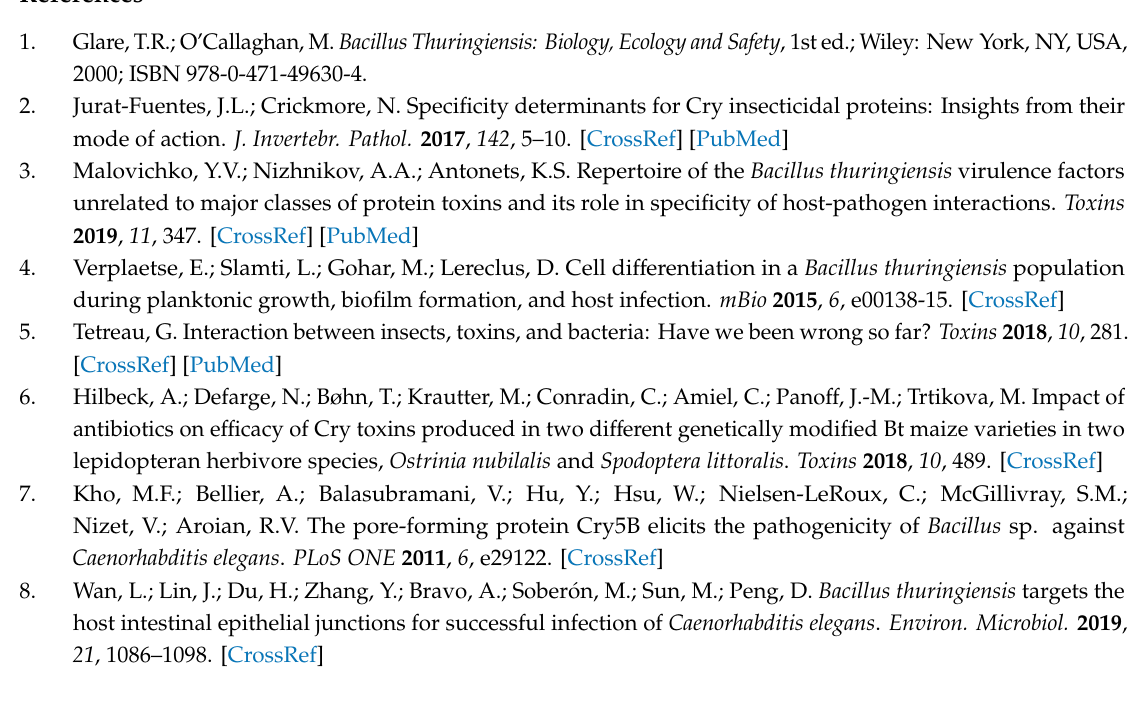
Figure S1: Appearance of the Smurf phenotype 48 h after death. Figure S2: Survival of 13-day-old T. castaneum larvae during exposure to B. thuringiensis var. tenebrionis and var. tolworthi . Table S1: Data on T. molitor . Table S2: Data on T. castaneum